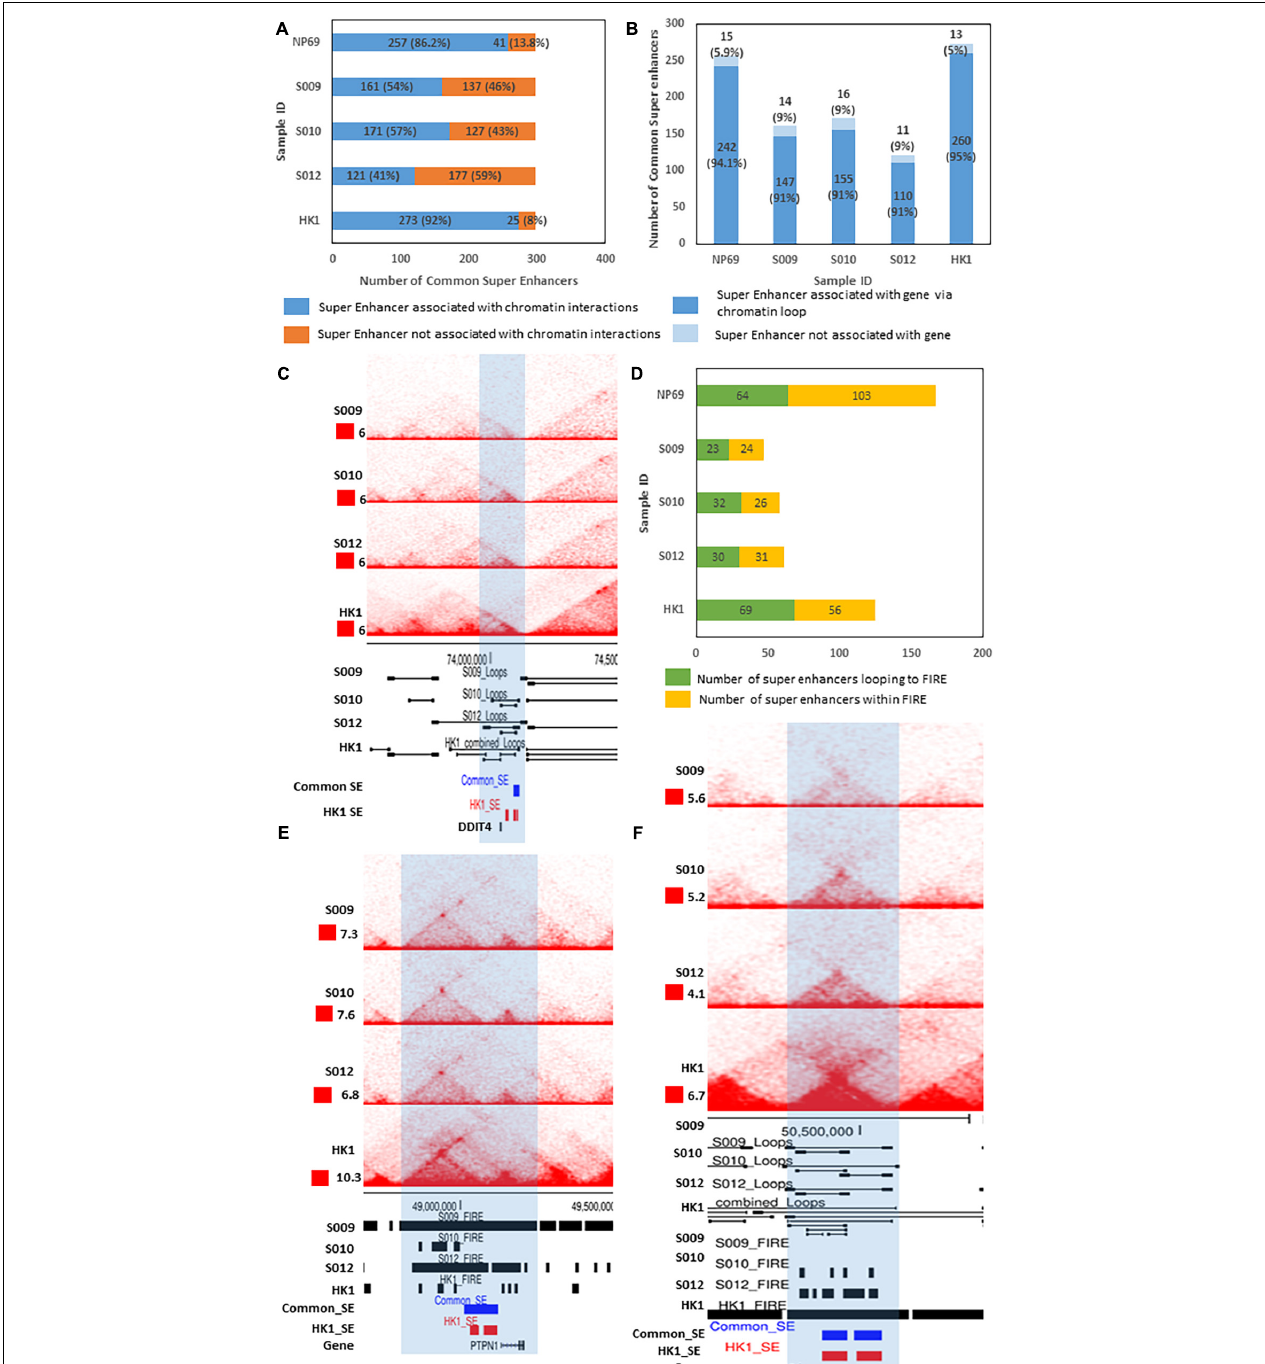
FIGURE 4 | Association of super enhancers with chromatin interactions and genes. (A) Graph showing the number of common SE associated with chromatin interactions (blue) and the number of SE which are not associated with chromatin interactions (orange). (B) Graph showing the number of looping SE (chromatin interaction-associated SE) associated with distant genes via chromatin loops (dark blue) and the number of SE (chromatin interaction-associated SE) which do not link to distant genes via chromatin loops (light blue). (C) Biop-C heatmaps for samples S009, S010, and S012 and Hi-C heatmap for the cell line HK1 for the DDIT4 gene locus (zoomed-in view of genomic locus chr10:72974237–75095236) where a SE links to the gene through a chromatin loop. (D) Graph showing the number of SE associated with FIREs via chromatin loop (green) and the number of SE which are within FIRE (yellow). (E) Biop-C heatmaps for samples S009, S010, and S012 and Hi-C heatmap for the cell line HK1 (zoomed-in view of locus chr20: 48422029–49905948) showing a SE (blue: common SE, red: HK1 SE) and PTPN1 gene within the same FIRE. (F) Biop-C heatmaps for samples S009, S010, and S012 and Hi-C heatmap for HK1 (zoomed-in view of locus chr14: 49,497,144–51,494,634) showing a SE looping to FIRE at the ARF6 gene